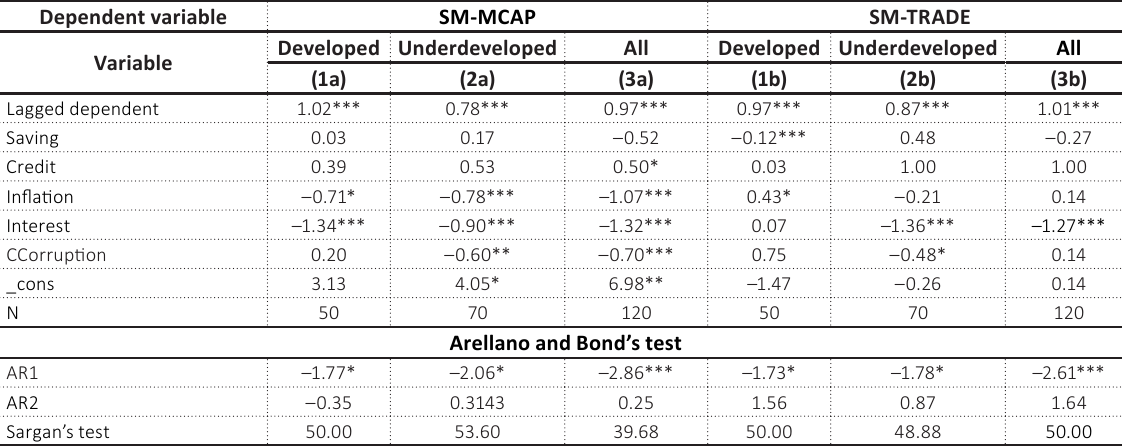
Table 2. Corruption affecting the development of the EAP stock